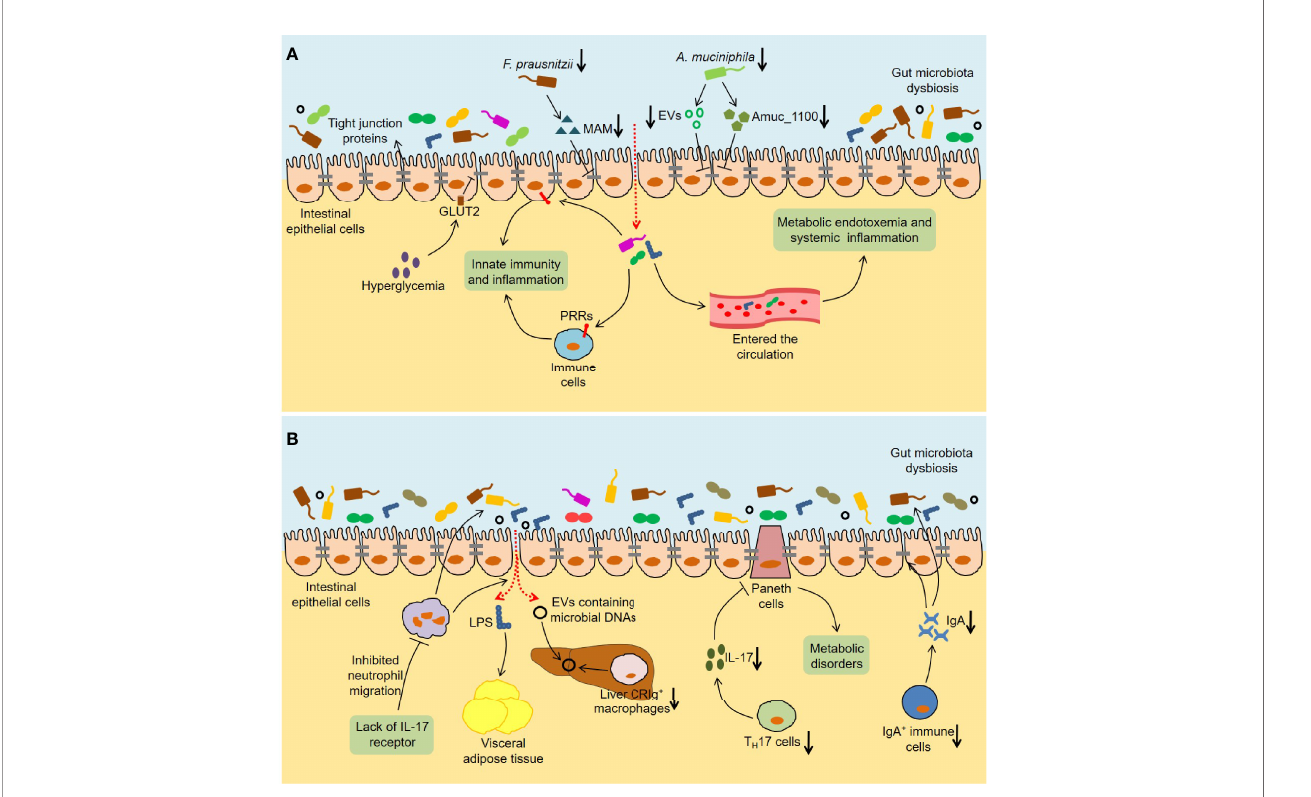
FIGURE 3 | Immune and in fl ammatory responses induced by the gut microbiota in T2DM. (A) The intestinal barrier is disturbed in T2DM. Hyperglycemia disrupts the integrity of tight and adherent junctions by GLUT2. F. prausnitzii abundance and its metabolite MAM levels are downregulated in db/db mice, which results in damaged intestinal barrier by reducing ZO-1 expression. Analogously, A. muciniphila abundance and the levels of A. muciniphila -derived EVs and Amuc_1100 are reduced in diabetic mice, which also disrupts intestinal barrier integrity. The increased intestinal permeability leads to the translocation of bacteria and bacterial products, which not only activates the innate immunity and in fl ammation in the gut, but also causes metabolic endotoxemia and systemic in fl ammation. (B) Multiple immune cells are involved in the in fl uence of the gut microbiota on host metabolism. Lack of IL-17 receptor promotes intestinal dysbiosis and LPS translocation into visceral adipose tissue by inhibiting the migration of neutrophils in the intestinal mucosa. Reduced liver CRIg + macrophages leads to an accumulation of EVs containing gut microbial DNAs in obesity, thereby promoting tissue in fl ammation and insulin resistance. The number of T H 17 cells is reduced in the intestinal tissues of obese mice, which leads to metabolic disorders by regulating the functions of Paneth cells. Furthermore, HFD-fed mice show a decrease in IgA + immune cell percentage and secretory IgA concentrations in colon tissues, which impairs glucose metabolism by increasing intestinal permeability and changing microbial composition. GLUT2, Glucose transporter 2; MAM, Microbial anti-in fl ammatory molecule; ZO-1, Zonula occludens-1; EVs, Extracellular vesicles; PRRs, Pattern recognition receptors; IL-17, Interleukin 17; LPS, Lipopolysaccharide; CRIg, Complement receptor of the immunoglobulin